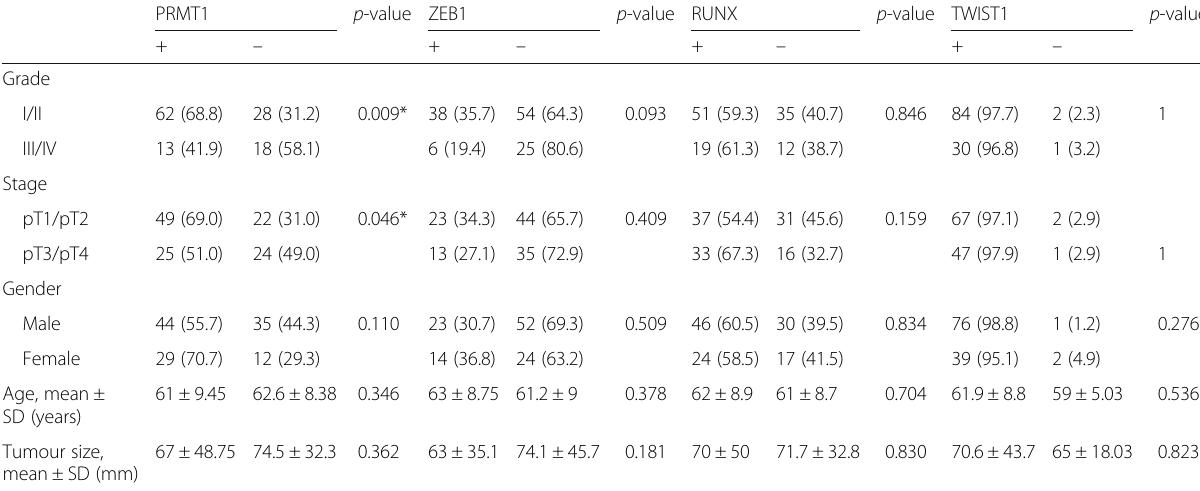
Table 5 The comparative analysis of PRMT1, ZEB1, RUNX1 and TWIST1 immunopositivity with clinic-pathological features of the patients with ccRCC PRMT1 p -value ZEB1